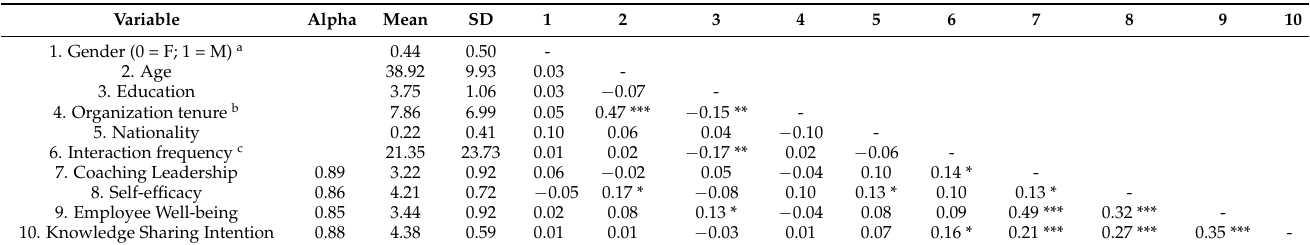
Table 1. Cronbach’s alpha, means, standard deviations, correlations, and reliabilities. Variable